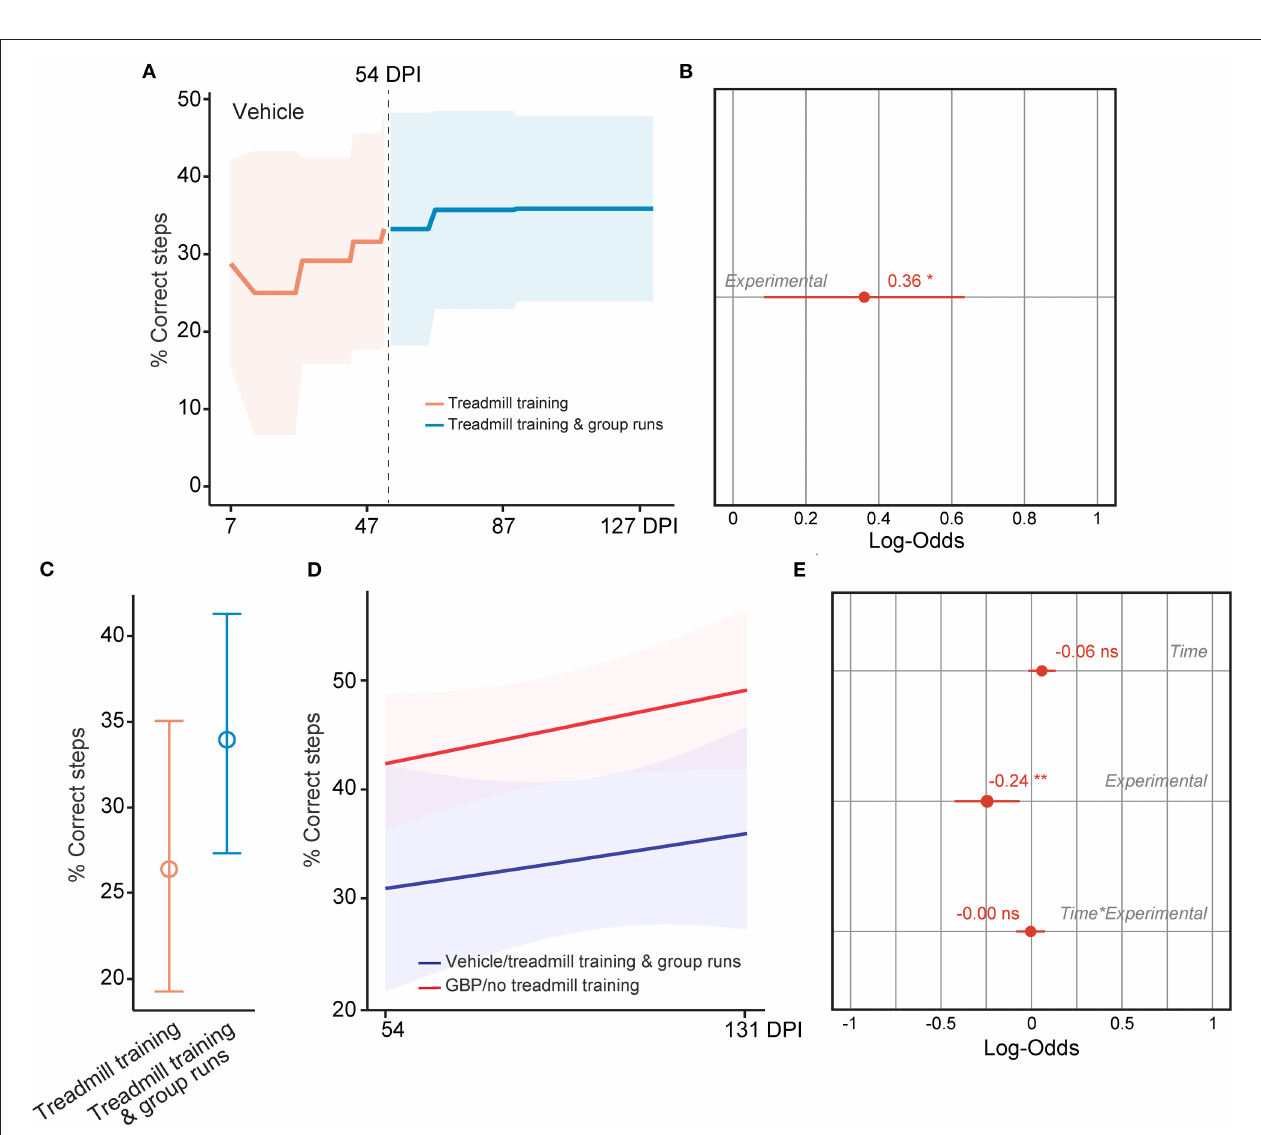
FIGURE 9 | Rescuing motivation promotes forelimb recovery in chronic SCI mice. (A) Recovery of forelimb skilled locomotor function in control mice was measured using the horizontal ladder rung-walking test. Mean and standard deviation (vehicle with treadmill training n = 13). (B) Analysis of (A). Variable effect (Variable ∼ 0 or pre vs. 1 or post 54 DPI) on forelimb skilled walking in SCI mice administered vehicle is displayed as coefficient with confidence intervals (Generalized linear mixed effect model for repeated measures * p < 0.05, vehicle with treadmill training n = 13). (C) Predicted changes in forelimb skilled locomotor function in SCI mice administered vehicle before and after implementation of group runs during treadmill training. Mean (value) and confidence intervals. (D) Predicted changes in forelimb skilled locomotor function in SCI mice administered vehicle after implementation of group runs during treadmill training or SCI mice administered GBP alone. Shaded error bands indicate confidence intervals. (E) Analysis of (D) . Variable effects on forelimb skilled locomotor function in SCI mice administered vehicle after implementation of group runs during treadmill training or SCI mice administered GBP alone are displayed as coefficients with confidence intervals (Generalized linear mixed effect model for repeated measures ** p < 0.01, ns not significant, vehicle n = 13 and GBP n = 25 mice). Of note, SCI mice administered GBP without treadmill training and group runs originated from our previous study (Sun et al., 2020).